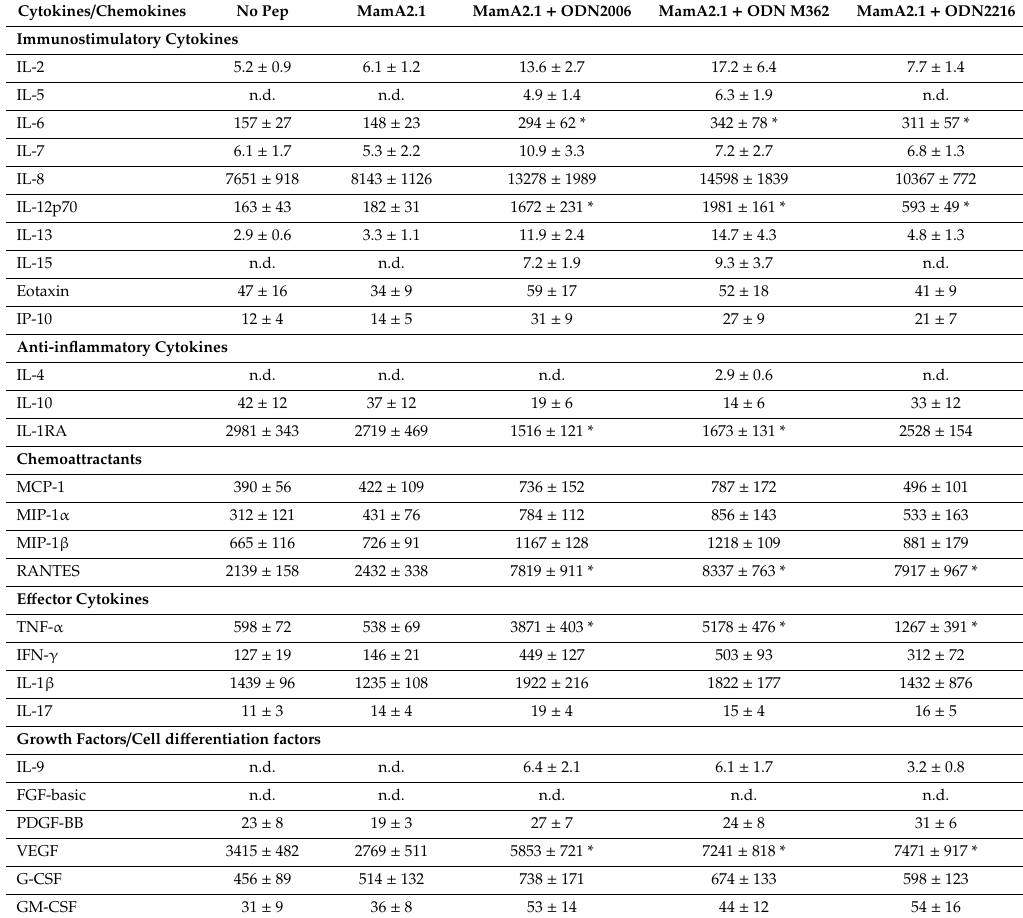
Table 1. Expression of cytokines / chemokines in THP-1 cells following treatment with various ODNs. All experiments were performed in four independent replicates, and protein values are presented as mean ± SD. * p < 0.05 (ANOVA, one-way) compared with the MamA2.1 peptide treatment alone. Cytokines /